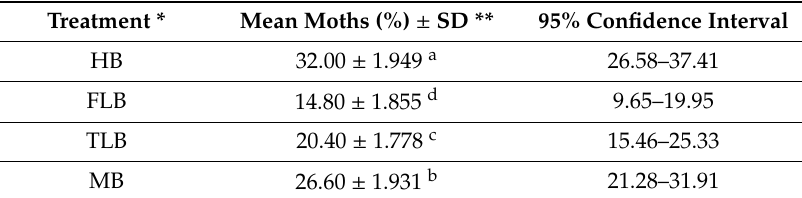
Table 3. Olfactory response of the DBM adult females to volatile blends emitted from multi-treated Barbarea vulgaris plants.